Question: Name the type of graph shown.
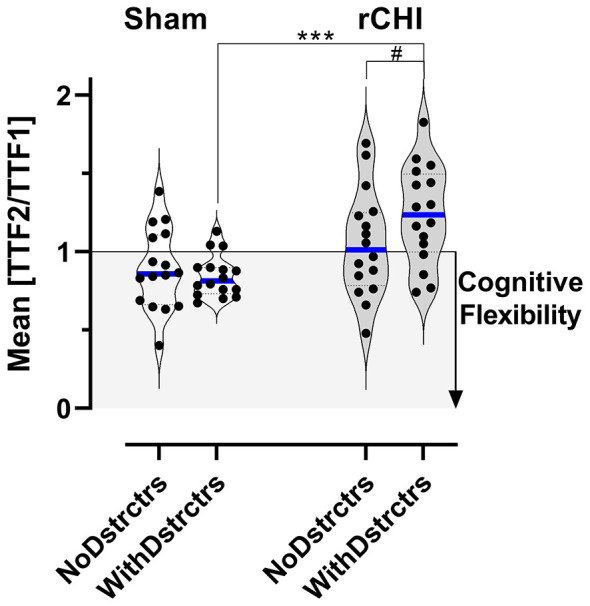
Answer: line